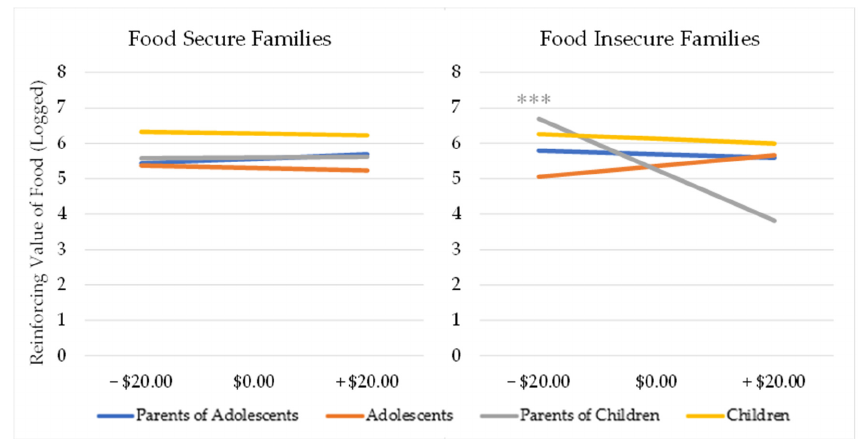
Figure 1. Changes in the RRV food following Acute Scarcity. Note: Food insecure parents of children reacted to financial losses by increasing their RRV food . Scores for RRV food are logged. *** = p <.001.